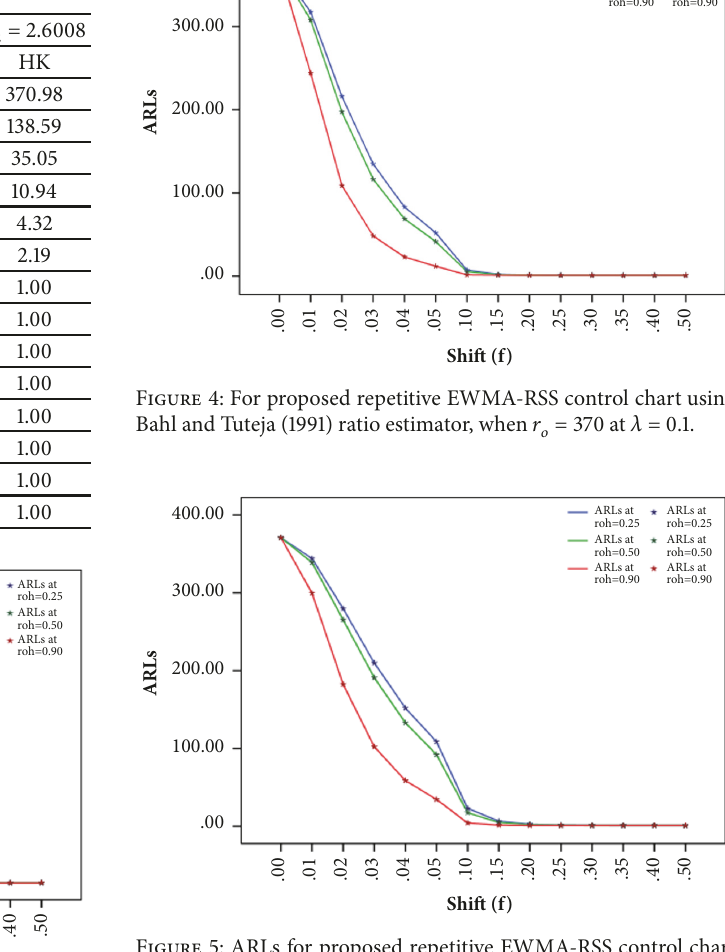
Table 18: Average run lengths for proposed repetitive EWMA-RSS control charts using exponential ratio-type estimators, for 𝜌 = 0.90 when 𝑟 𝑜 is 370 at 𝜆 = 0.1.